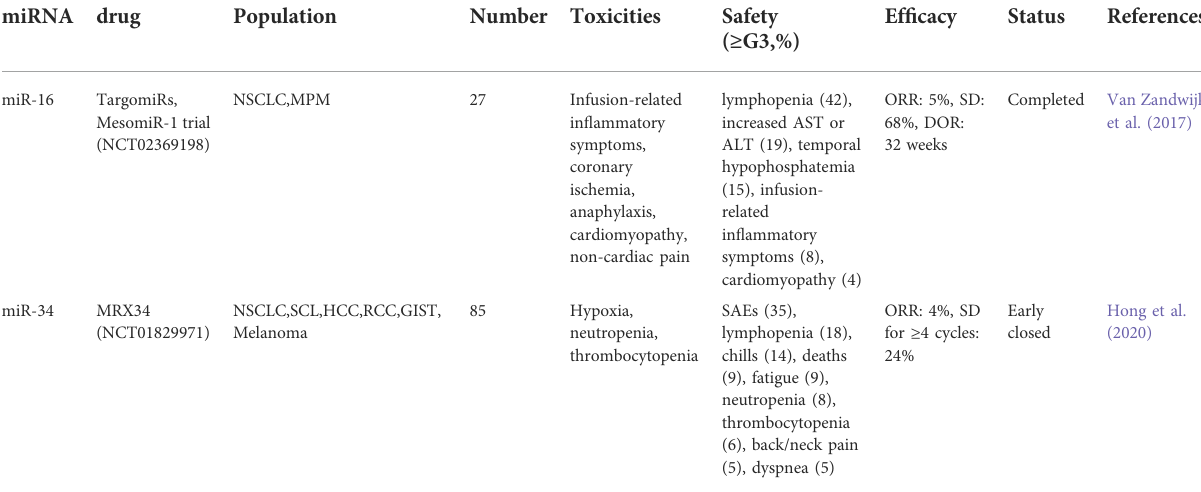
TABLE 3 NSCLC clinical trials with miRNA-based therapy. miRNA